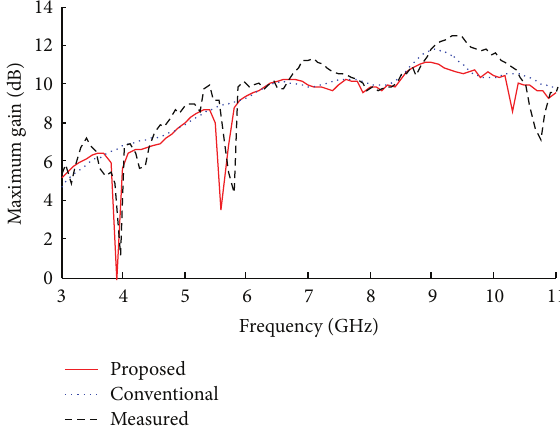
Figure 8: Peak gain for both conventional and proposed